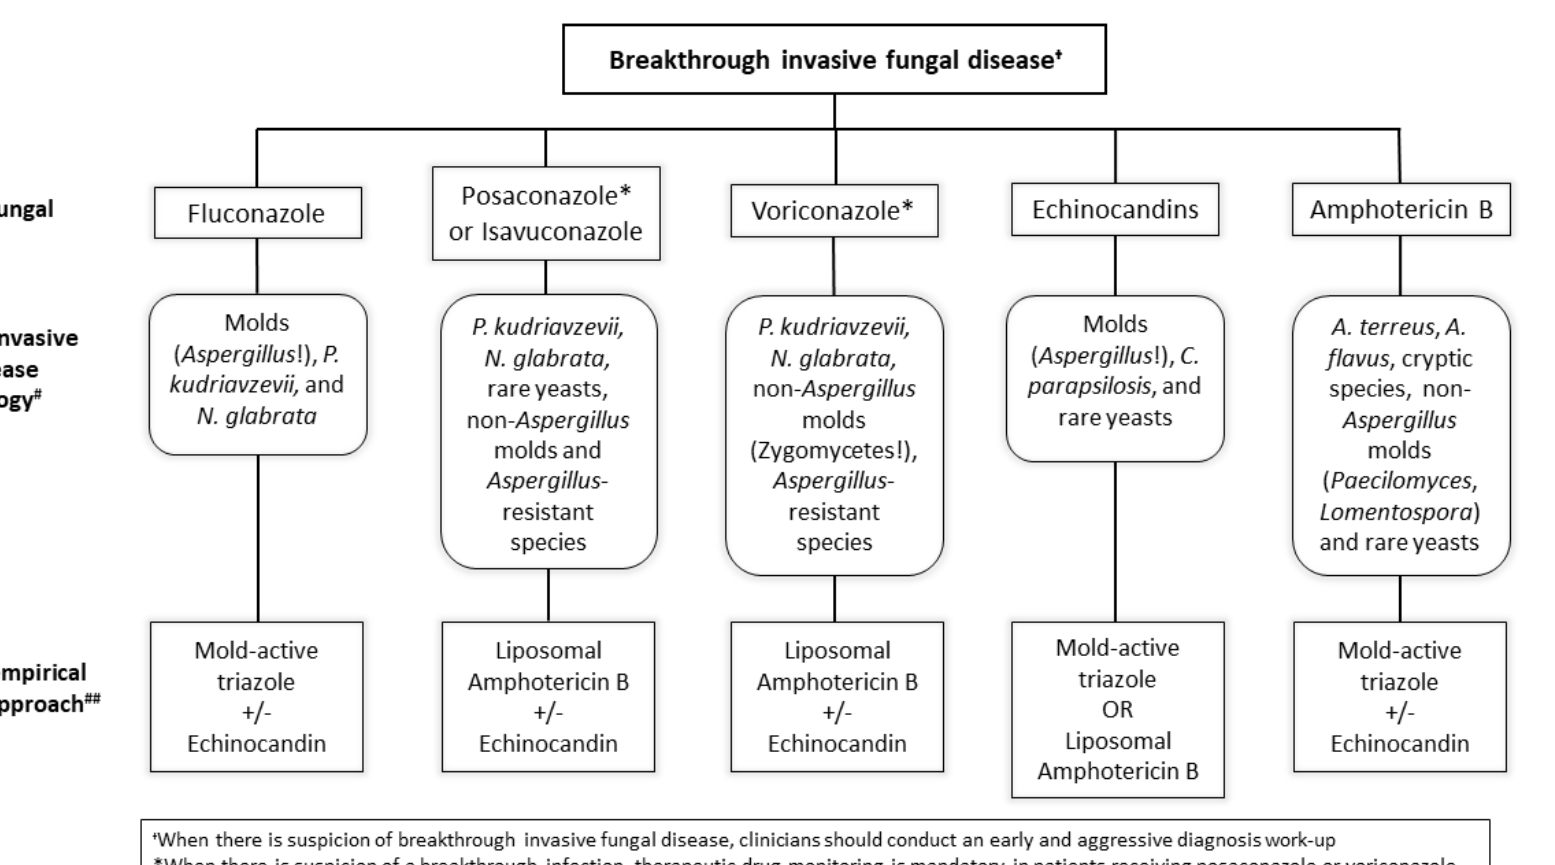
Figure 1. Algorithm of expected breakthrough invasive fungal disease epidemiology per prior antifungal therapy and suggested empirical treatment.